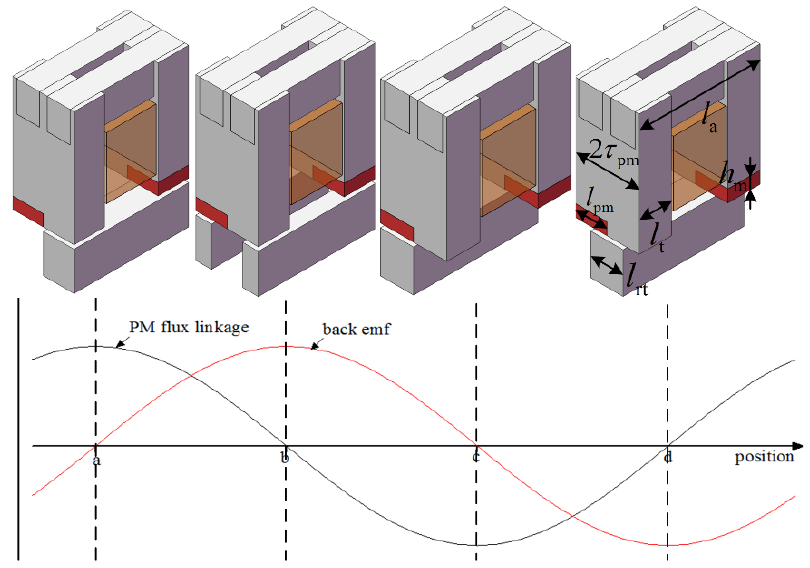
Figure 1. Fundamental structures. ( a ) FRM, ( b ) TF − FRM, ( c ) proposed TF − CFRM, ( d ) stator of single- phase unit of TF − CFRM, and ( e ) structure of three-phase TF − CFRM.